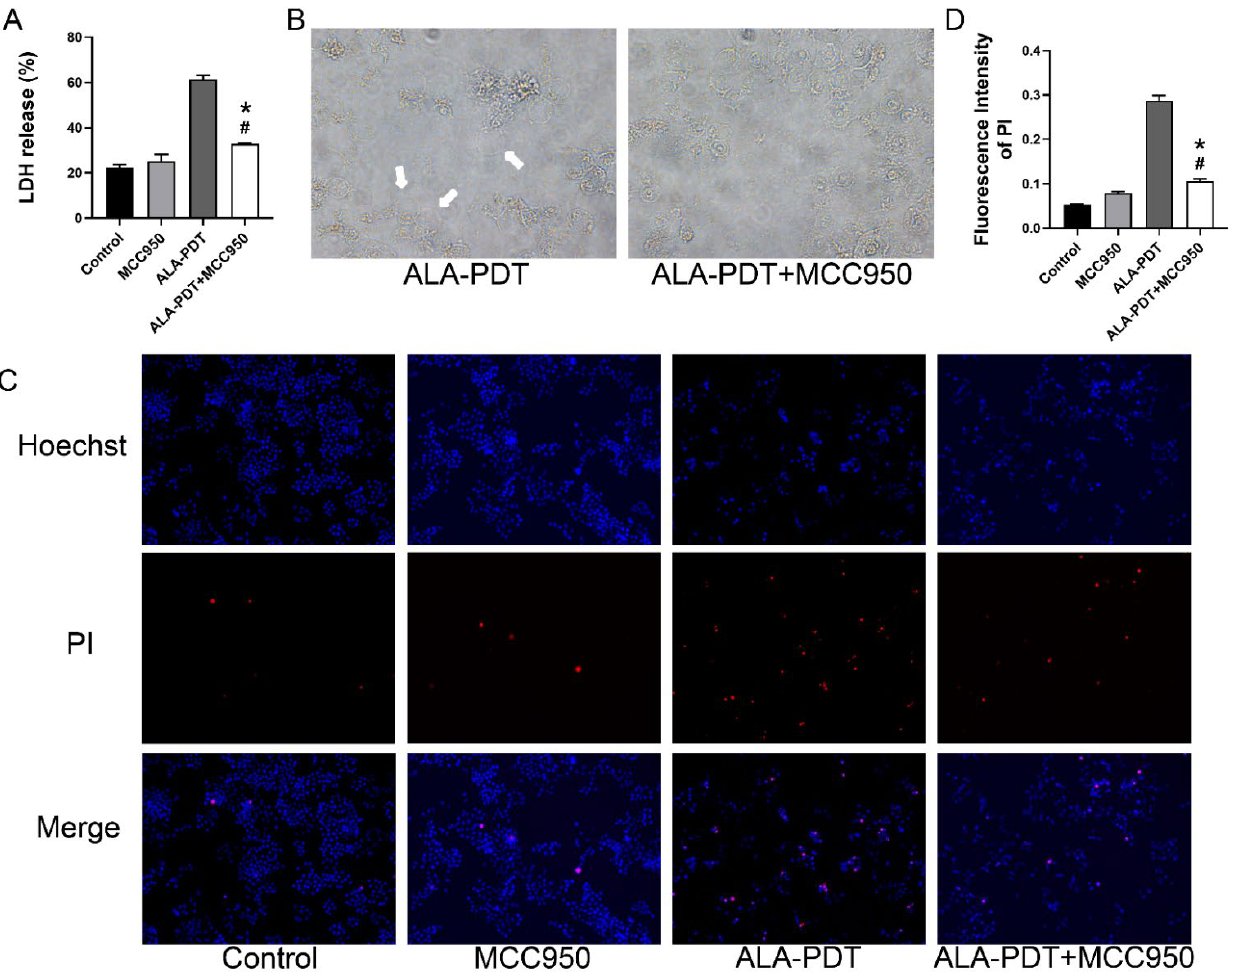
Figure 7. MCC950 abrogated the pyroptotic morphology induced by ALA-PDT in HeLa cells. ( A ) ALA-PDT combined MCC950 reduced the release of LDH. * p < 0.05 compared with ALA-PDT group. # p < 0.05 compared with the control group. ( B ) The morphologic change of HeLa cells after ALA-PDT combined MCC950 in bright field (400×). White arrowheads indicated the large bubbles emerging from the cell membrane. ( C ) Hoechst/ PI staining assay in HeLa cells after ALA-PDT combined MCC950 (100×). ( D ) Statistical analysis of the fluorescence intensity of PI-positive cells. * p < 0.05 compared with ALA-PDT group. # p < 0.05 compared with the control group.